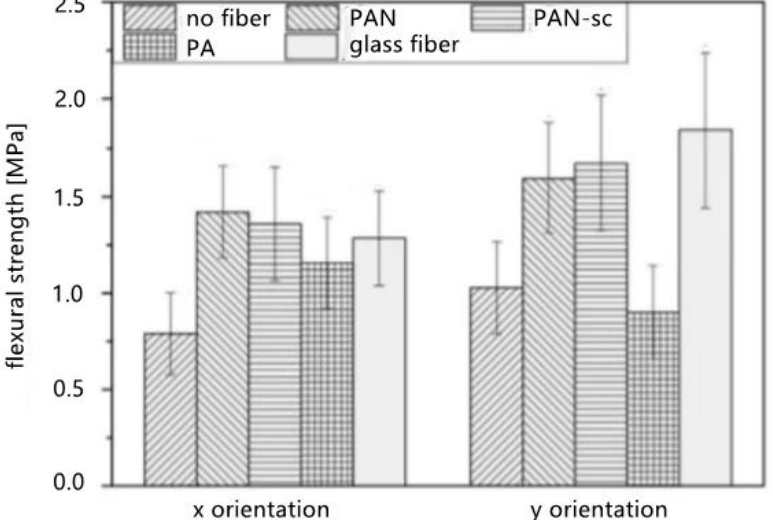
Figure 9. Flexural strength of fiber-reinforced samples printed in x and y direction. Reprinted with permission from ref. [41]. Copyright 2014 Elsevier